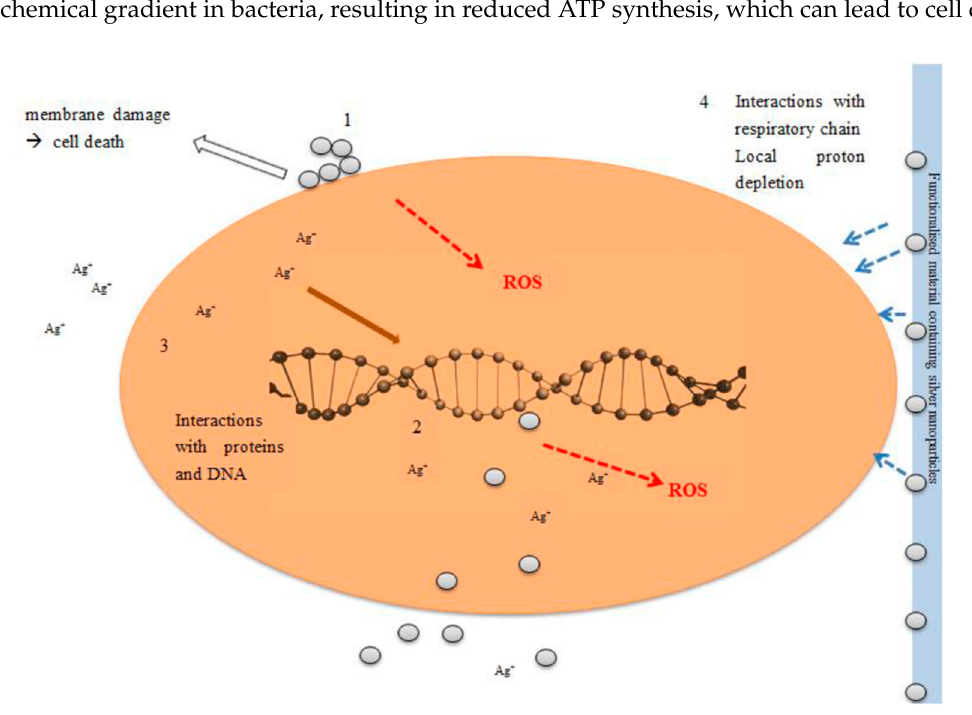
Figure 3. Schematic representation of the known mechanism(s) of antibacterial action of silver nanoparticles and released ionic silver. The numbers 1–4 correspond to the mechanisms described in the paragraphs above. Grey circles indicate silver nanoparticles (NPs) and Ag + implies ionic silver released from the NPs. Reproduced with permission from Reidy et al. [37].